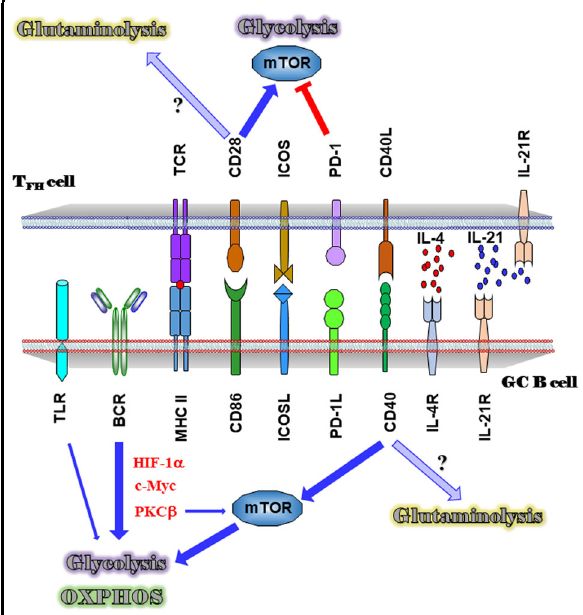
Fig. 1 Metabolic consequences of the cross-talk between GC B cells and T FH cells. BCR- or TLR-mediated activation induces glycolysis and OXPHOS in GC B cells via HIF-1 α , c-Myc, and PKC β . CD40 signaling is necessary to activate mTOR following this increased glycolysis and OXPHOS for GC B-cell survival and proliferation. Engagement of PD-1 expressed on T FH cells with PD-1L expressed on GC B cells independently inhibits glycolysis, whereas CD28 signaling increases glycolysis in T FH cells. Glutaminolysis is required by GC B cells and T FH cells. Its potential activation by CD28 signaling in T FH cells and CD40 signaling in GC B cells needs to be